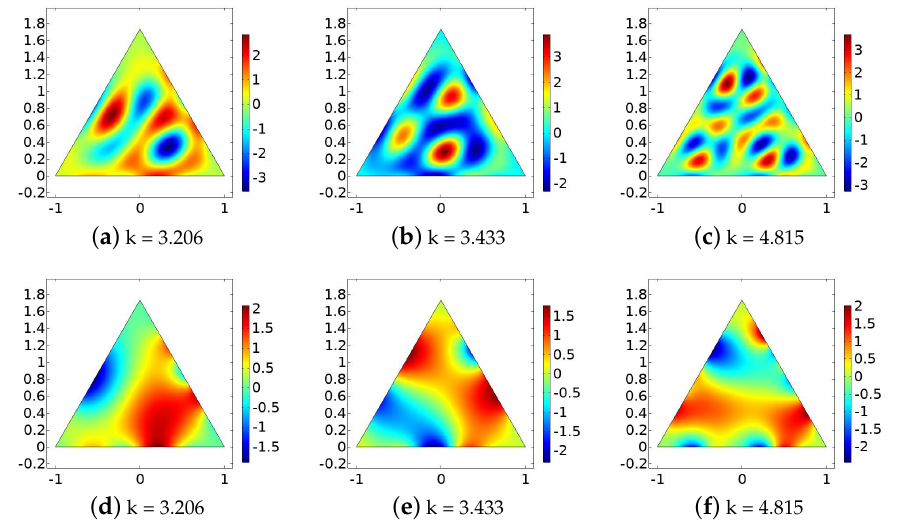
Figure 5. The magnitude of transmission eigenfunctions for an equilateral triangle with different eigenvalues. ( a – c ): eigenfunctions w ’s; and ( d – f ): eigenfunctions v